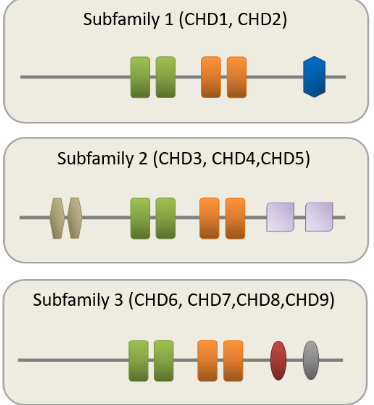
Figure 1. Schematic representation of the mammalian CHD family with conserved domains shown for each subfamily. The signature motif of the entire CHD family is an N ‐ terminal tandem chromodomain (green boxes) responsible for chromatin binding. The central SNF2 ‐ family ATPase domain consists of two lobes (orange boxes) with each containing 2 tandem RecA ‐ like folds parts known as DExx and HELIC. The ATPase domain uses ATP hydrolysis to guide toward translocation down the DNA minor groove. CHD1 and CHD2 contain a C ‐ terminal DNA ‐ binding domain (blue box) that is replaced by a pair of PHD zinc ‐ finger ‐ like domains (purple boxes) in CHD3 to CHD5. Additional PHD domains localize to the N ‐ terminus (olive boxes). The third subfamily, consisting of CHD6 to CHD9, is in the C ‐ terminus more variable and contains functional motifs like SANT (red oval) or BRK (grey oval) domains. SANT domains support association with histone tails, while the BRK domain is also found in several SWI/SNF complexes. Schematic adapted from [11], attribution CC BY.